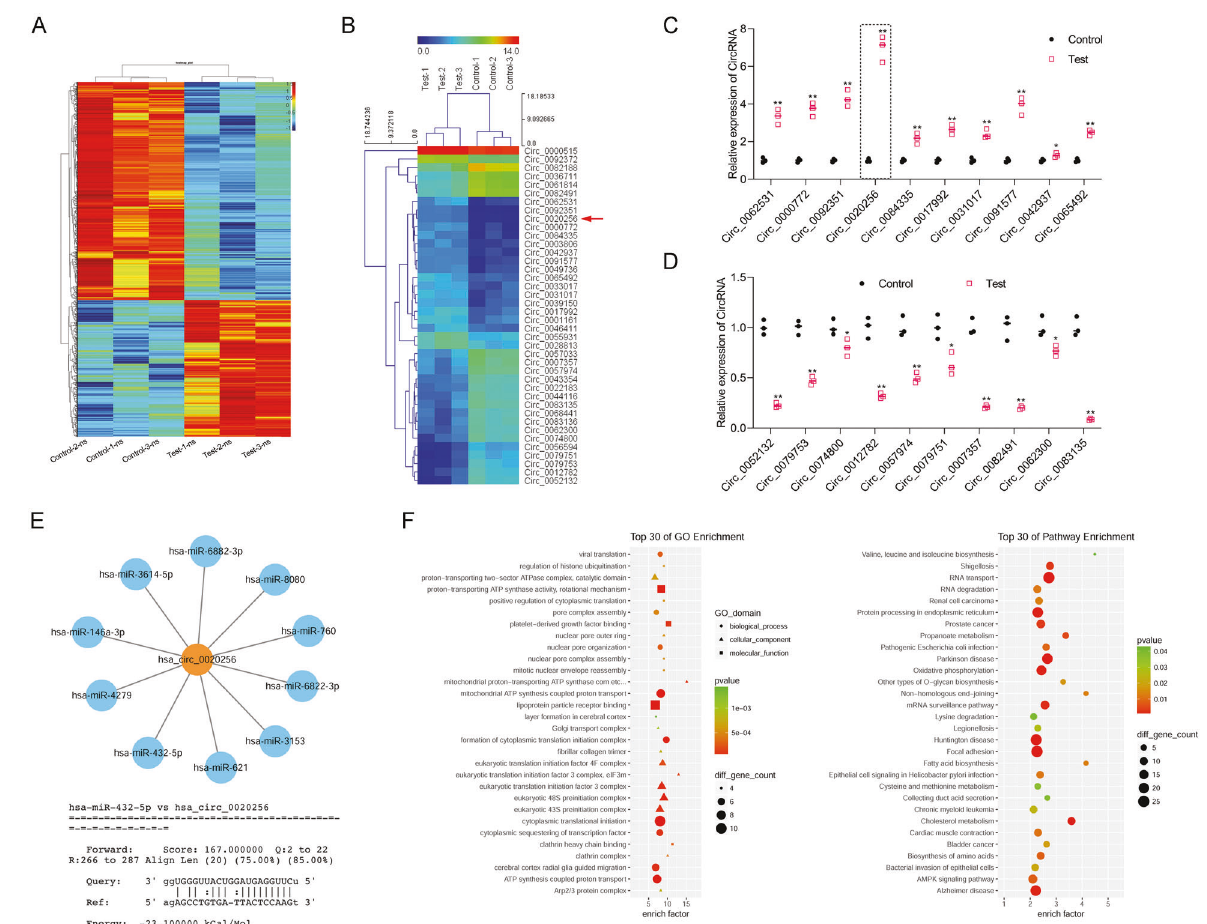
Fig. 3 Existence of differentially expressed CircRNAs in the TAM-secreted exosomes. A RNA was extracted from the exosomes secreted by TAMs. Differentially expressed genes are shown by a heatmap. Totals of 495 upregulated CicrRNAs and 789 downregulated CircRNAs were detected. ns, normalized signal. B The top 20 upregulated and downregulated CircRNAs are shown. C , D CircRNAs that were upregulated or downregulated in supernatant exosomes were identi fi ed by real-time PCR (control: PMA- and TWEAK-treated THP-1 cells, test: PMA + IL-4 and TWEAK-treated cells). E Based on a bioinformatics analysis of targeted binding miRNAs (predicted binding energy), ten miRNAs with the highest binding free energy scores were selected (upper panel). MiR-432-5p had the highest binding energy for hsa_Circ_0020256 (lower panel). F Top 30 of GO enrichment top 30 of pathway enrichment were